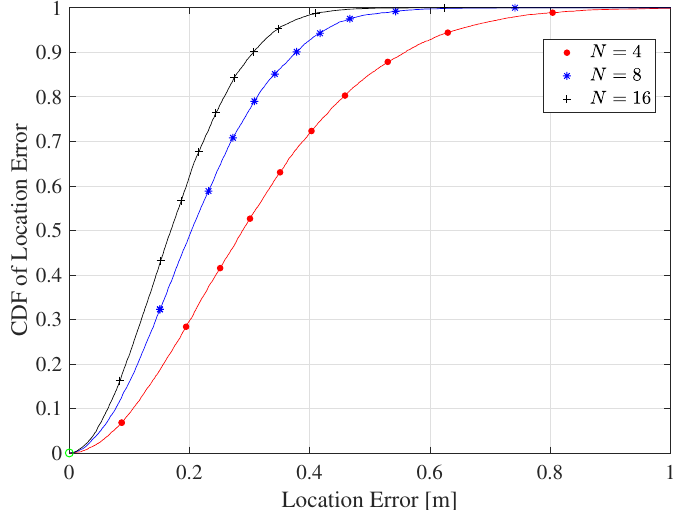
Figure 15. The CDF of the RMSE for different numbers of nested reference tags for the LOS environment and the co-polarized antenna configuration.